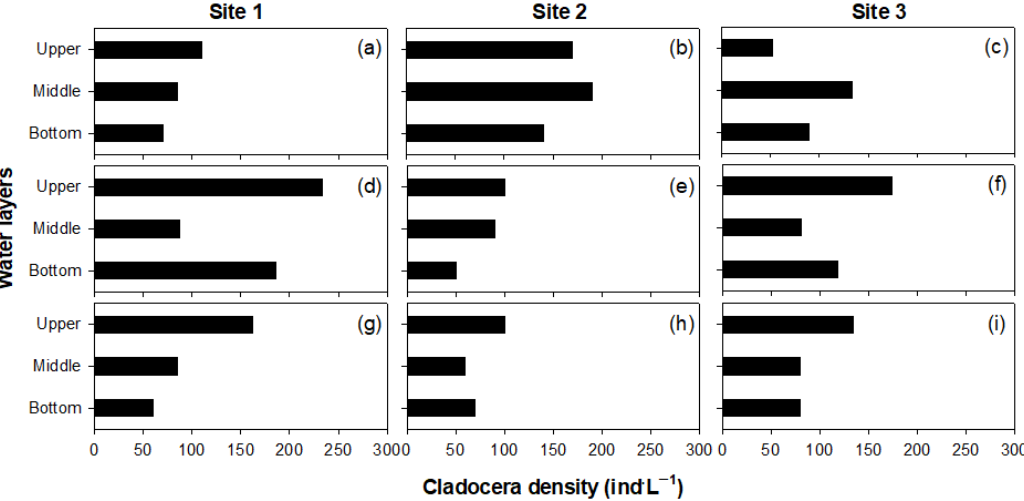
Figure 2. Seasonal vertical distribution of cladocerans in the Nakdong River Estuary. Spring ( a – c ), summer ( d – f ), and autumn ( g – i ) for sites 1, 2, and